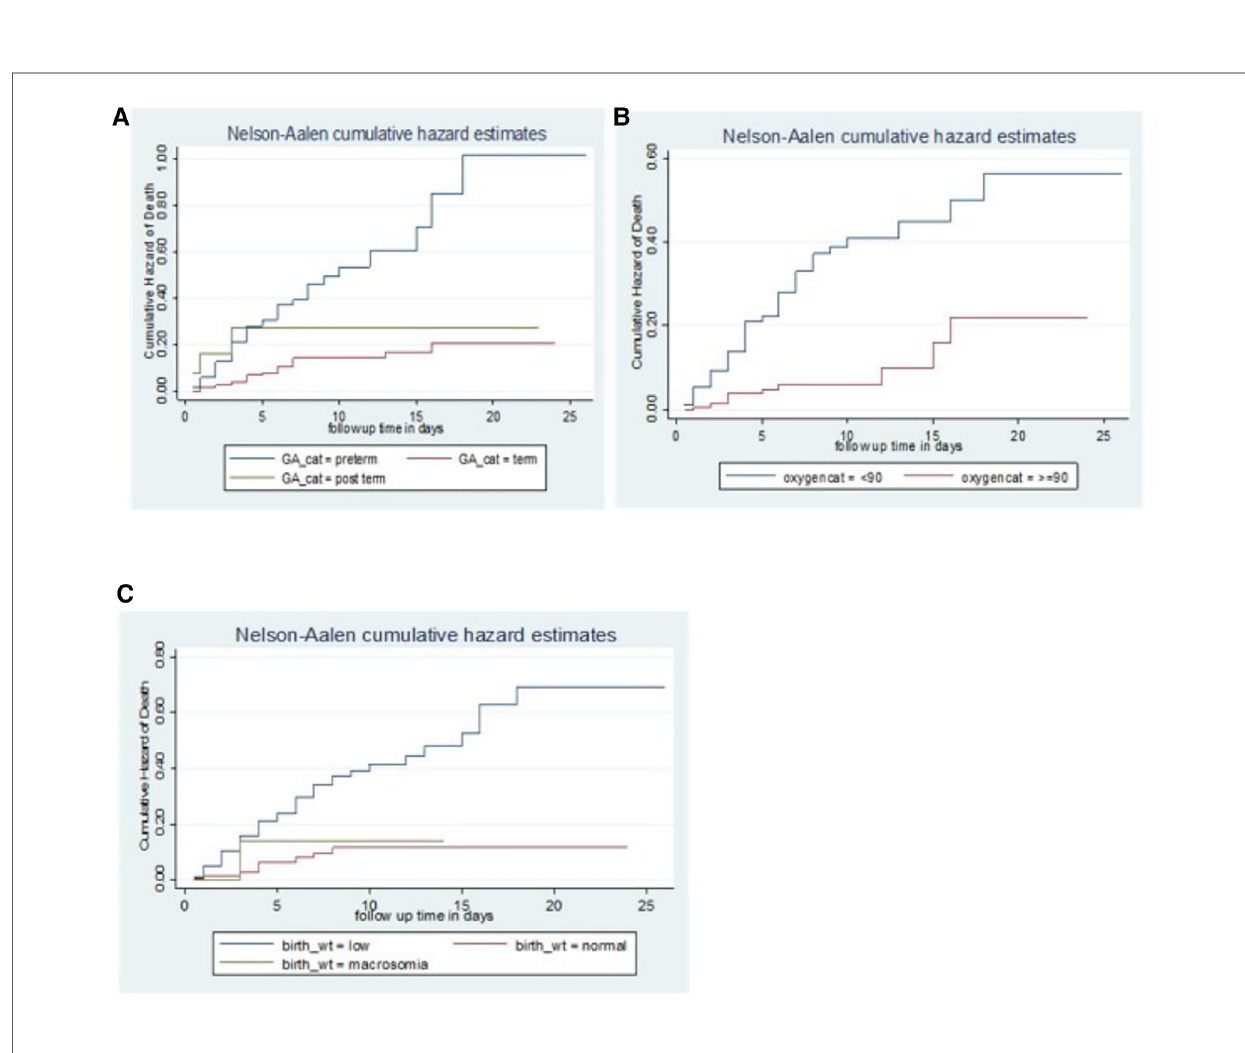
FIGURE 2 Nelson – Aalen cumulative hazard curve showing different hazards across different categories of the covariates (gestational age ( A ), oxygen saturation ( B ), and birth weight ( C